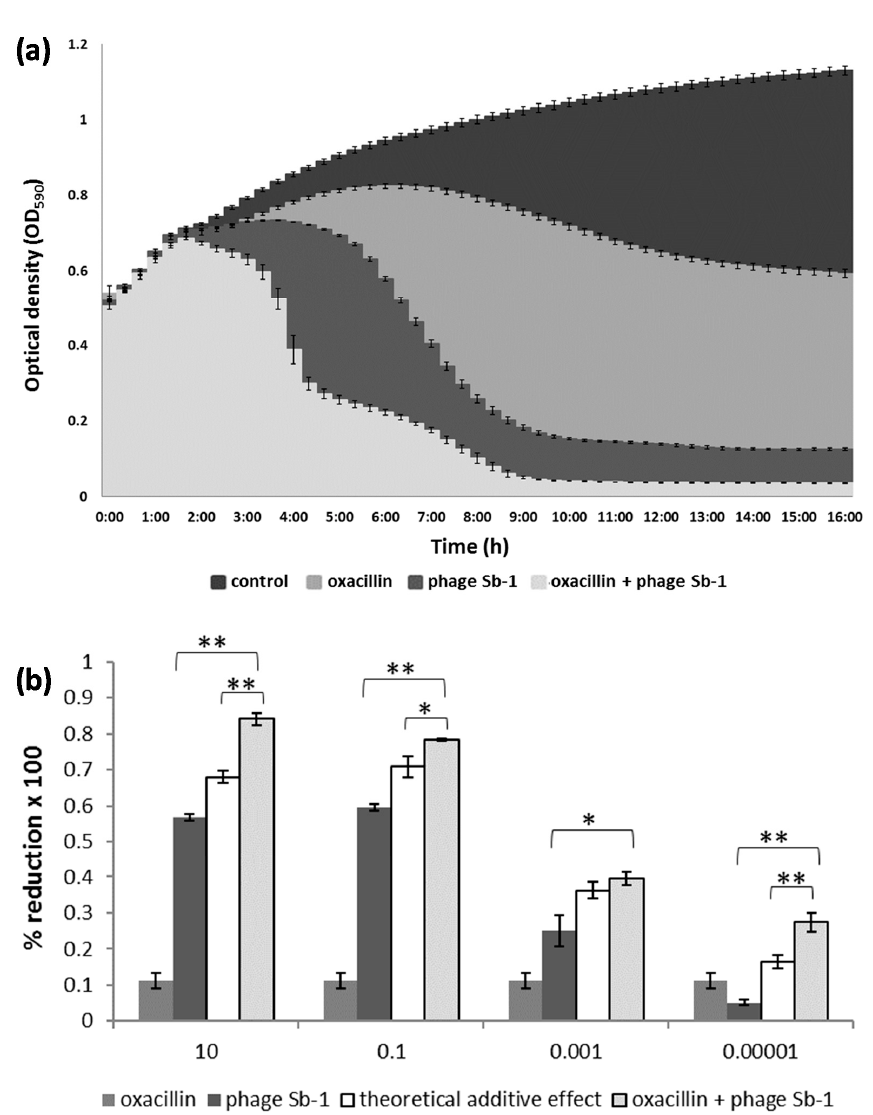
Figure 1. Interaction between phage Sb-1 and oxacillin against the MRSA clinical isolate SA19. ( a ) The mean bacterial density (OD 590 ) of three biological replicates over time is shown using the phage at an MOI of 0.1 and oxacillin at a concentration of 10 µg/mL in liquid medium. ( b ) The percentage of bacterial reduction based on the area under the curve (AUC) of the treated bacteria in relation to the AUC of the untreated bacteria, using phage MOIs ranging from 10 to 0.00001. The bars represent the mean reduction of each treatment for three biological replicates ± standard deviations. The stars indicate statistical support for an enhanced antibacterial effect of the dual approach in comparison with the effect of the phage alone or with the theoretical additive effect. ** p < 0.01. * p <